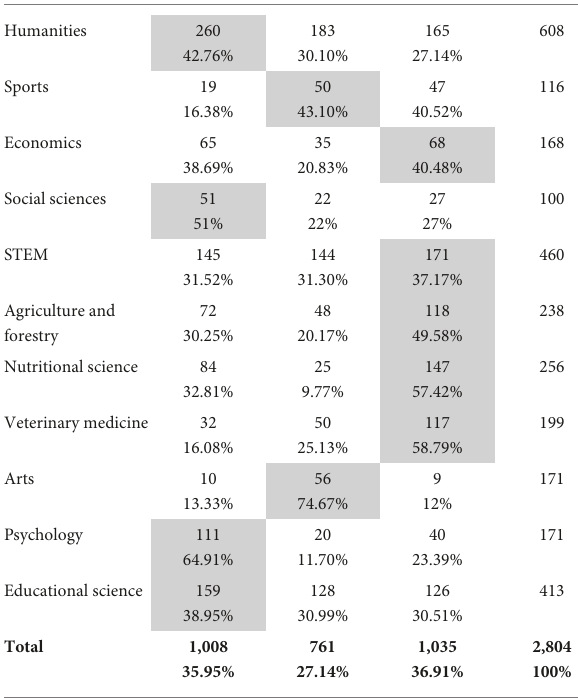
TABLE 5 Distribution of the fields of study across the profiles for learning